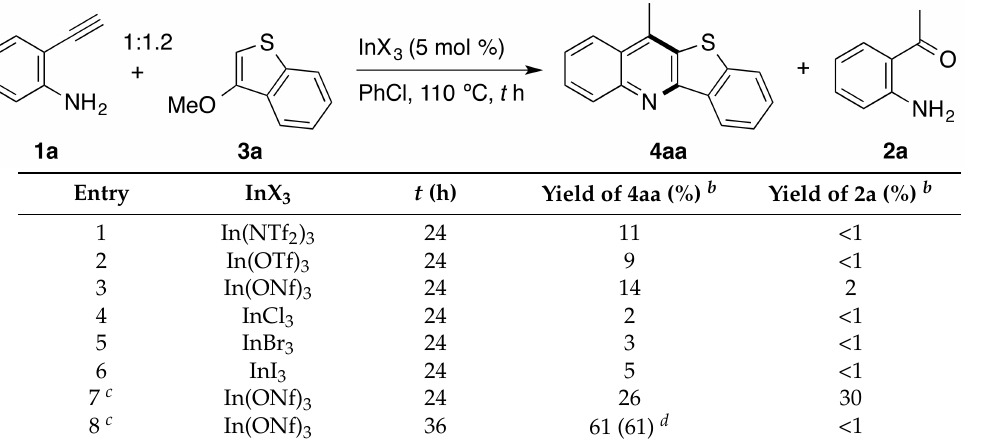
Table 1. Indium-catalyzed annulation of o -ethynylaniline with 3-methoxybenzothiophene a